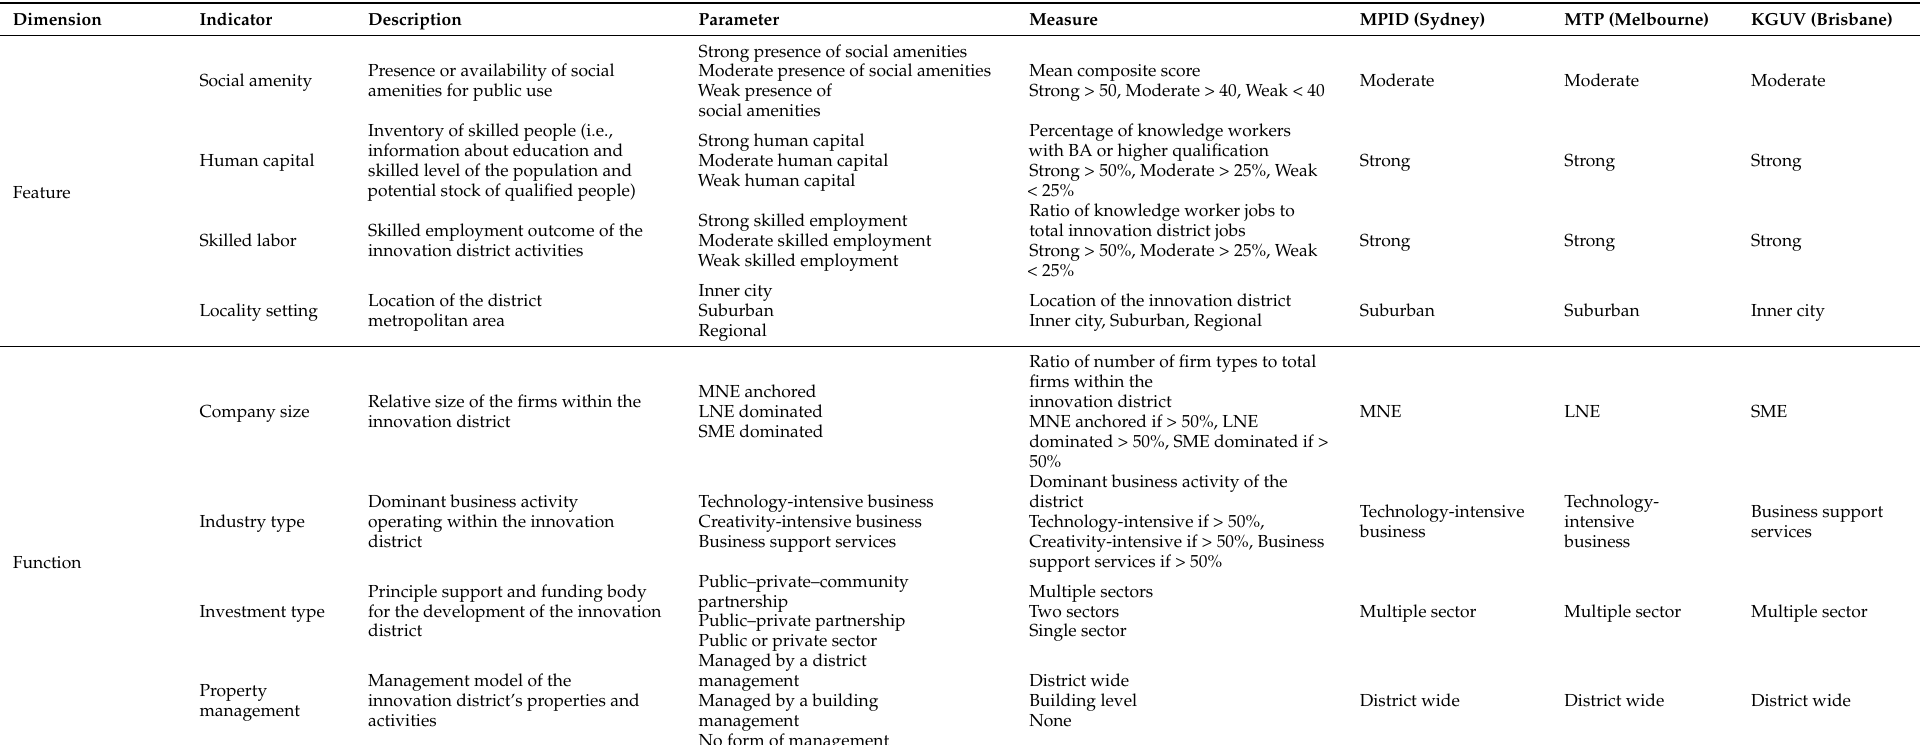
Table 2. Case study